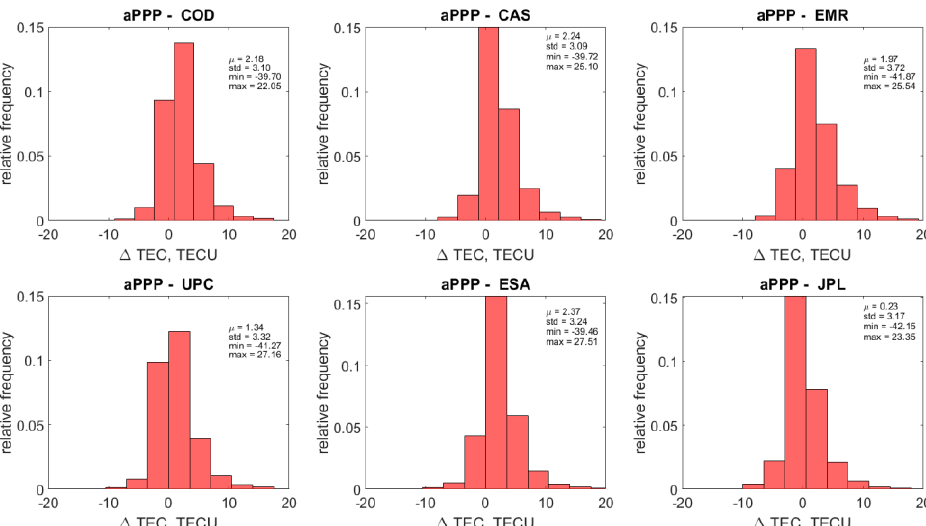
Figure 16. Distribution of the differences between Vertical TEC values retrieved using the ionosphere retrieval equation (labeled as aPPP) and GIM VTEC values from six different Ionosphere Associate Analysis Centers (IAAC) for GALILEO.